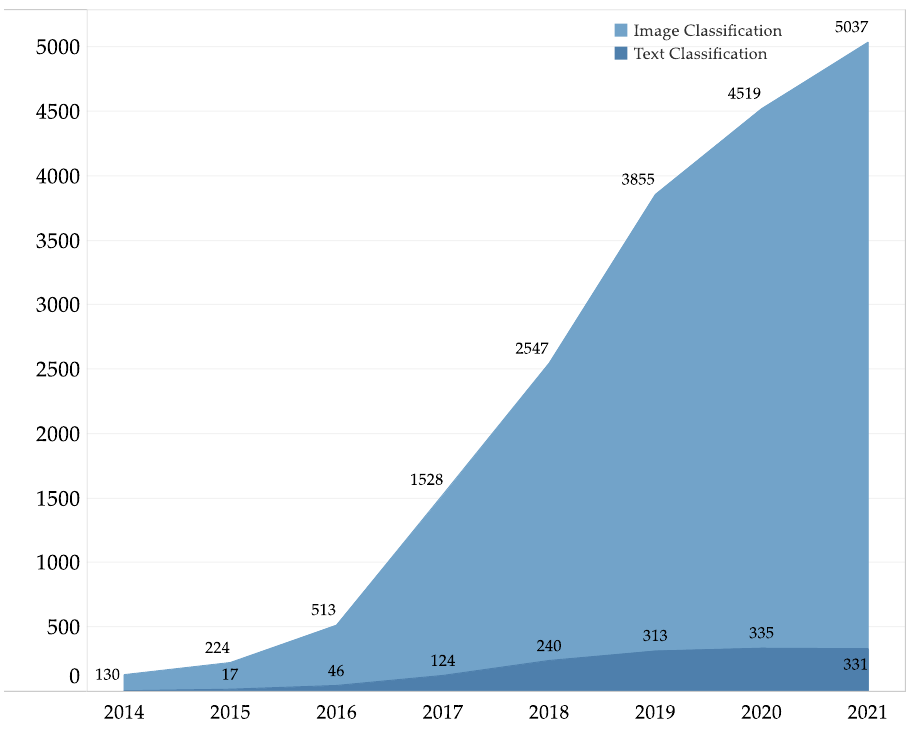
Figure 1. The number of CNN studies in the two applications.